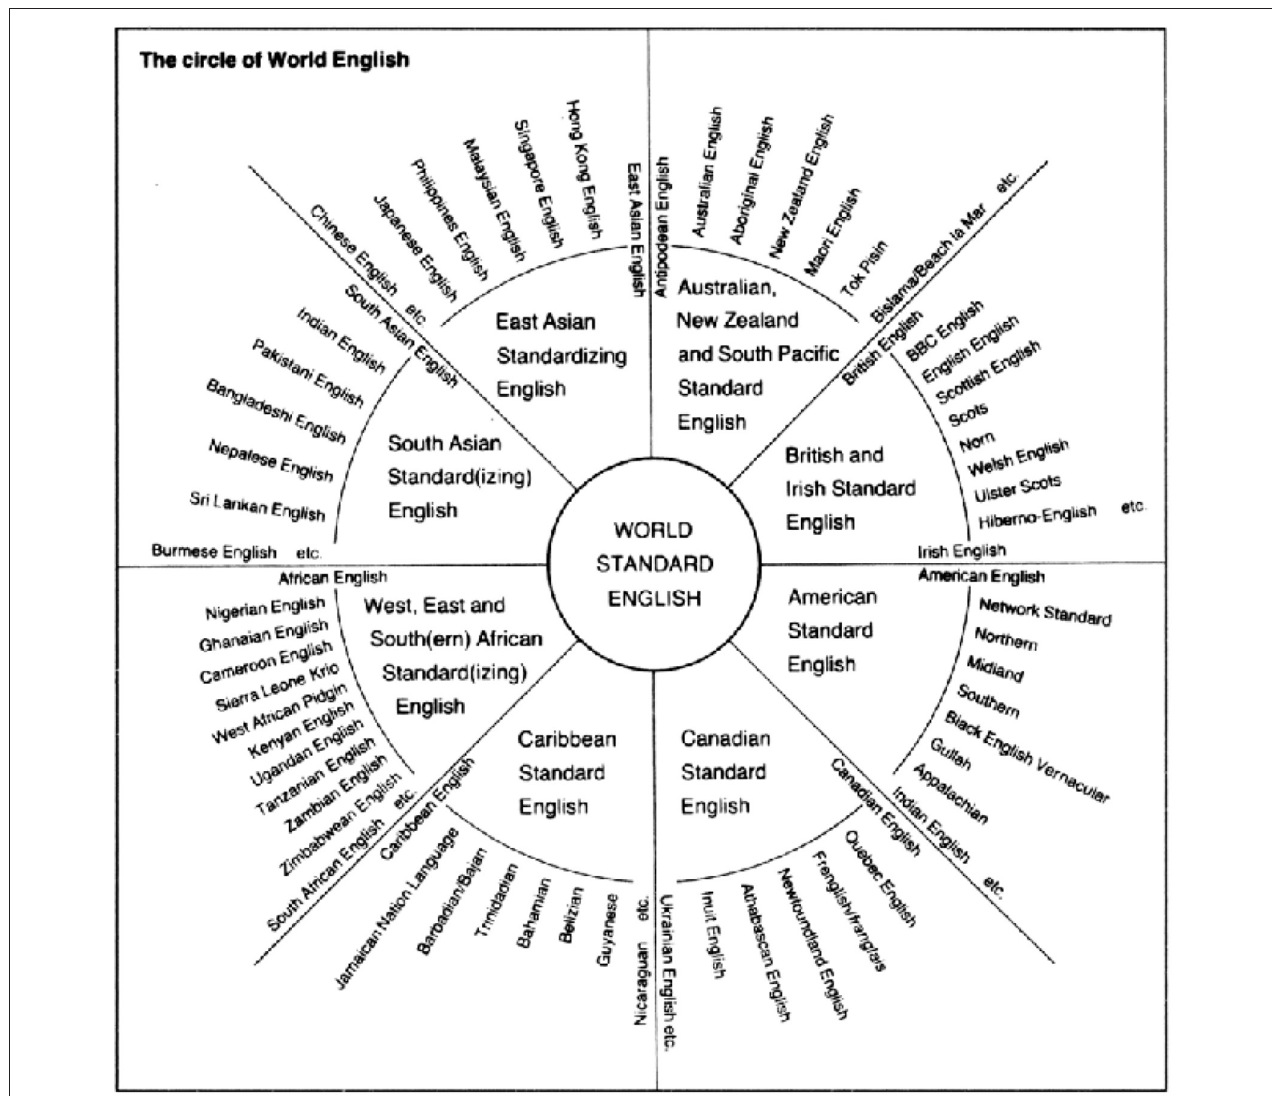
FIGURE 2 | McArthur’s “The Circle of world English” (from McArthur, 1987, p. 11).